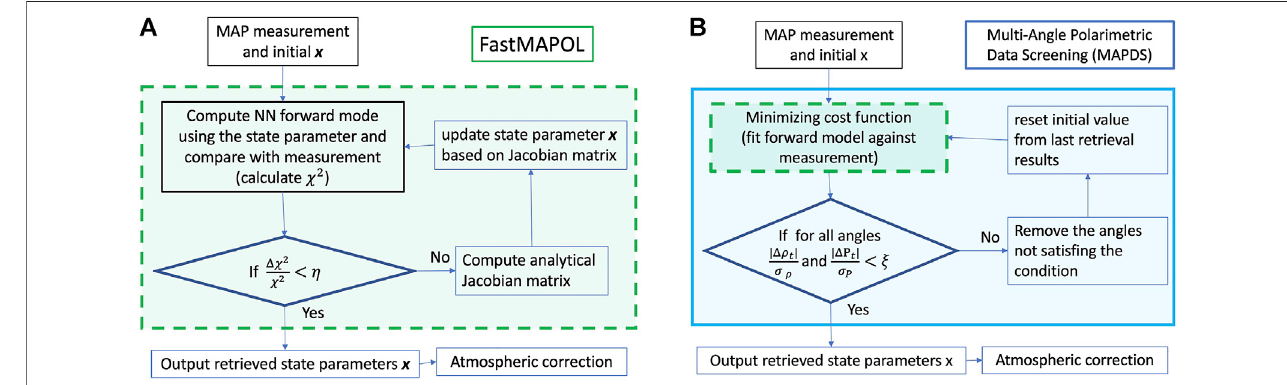
FIGURE 1 | Flowcharts for (A) FastMAPOL retrievals and (B) retrievals with the multi-angle polarimetric data screening (MAPDS). In panel (A) , Δ χ 2 (cid:2) | χ 2 i − χ 2 i − 1 | indicatesthechangesofthecostfunctionbetweentwoiterationswith η asthreshold( Eq.6 ).Inpanel (B) , Δ ρ t and Δ P t indicatethedifferencebetweenforwardmodeland measurements for re fl ectance and DoLP with ξ as threshold ( Eq. 8 ). The dashed box in (B) represents the same retrieval process as shown in the dashed box in (A) . A maximum three passes (indicated by the loop in (B) ) are used in the data screening process.